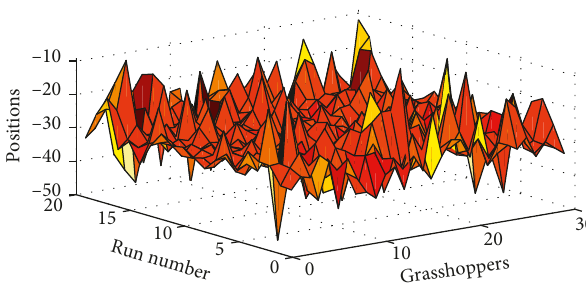
Figure 5: Results of ECGOA8 for unimodal function 1.